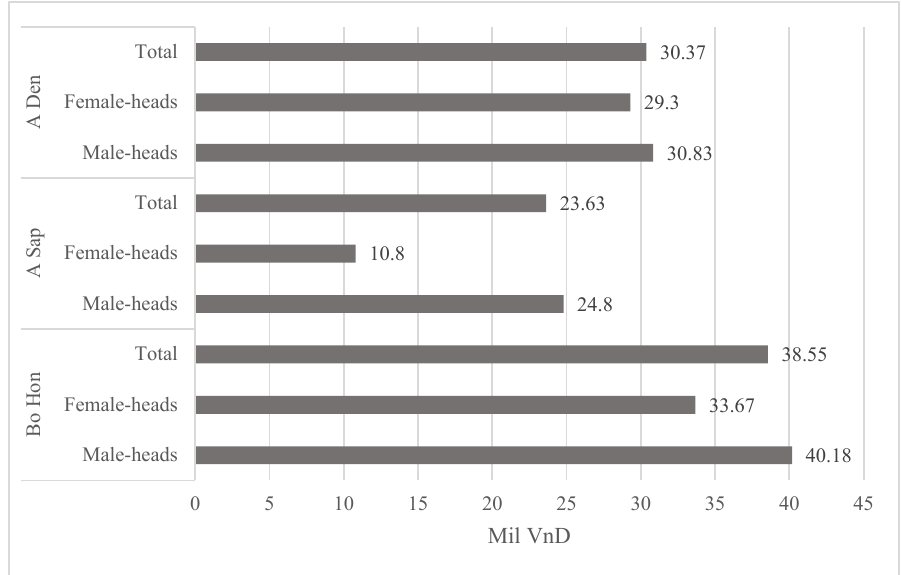
Figure 4. Average household annual income by gender.